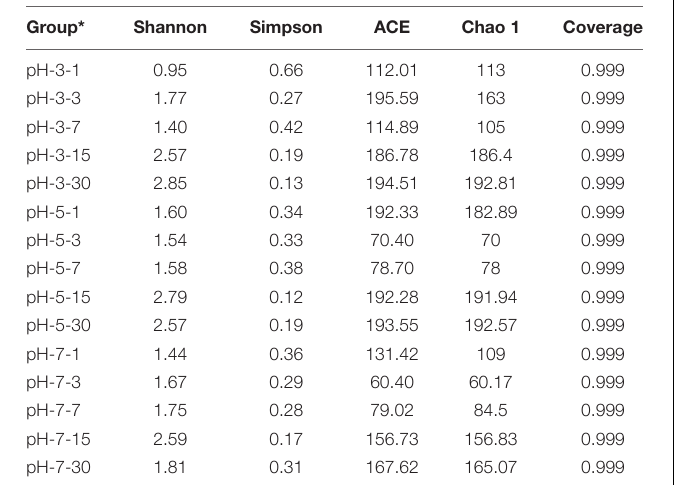
FIGURE 3 | Microbial community structure at the phylum level under different